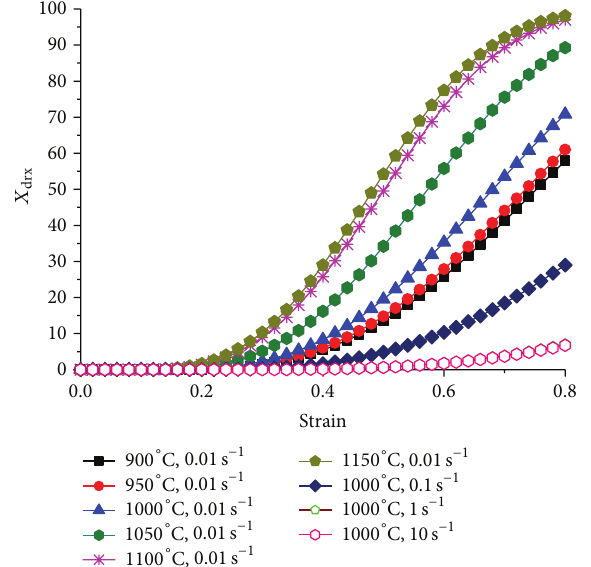
Figure 16: Volume fraction of DRX obtained at different tempera- tures and strain rates.